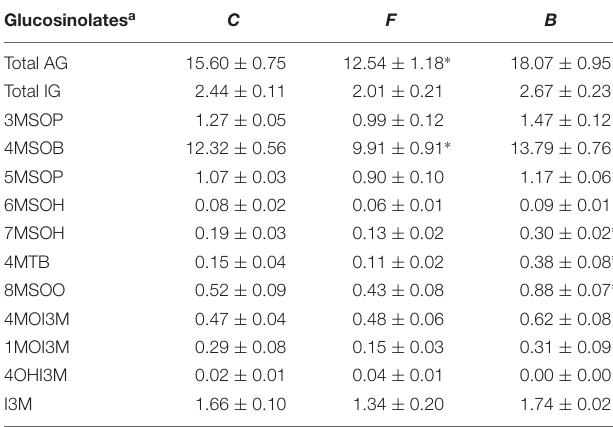
TABLE 2 | Mean ( ± SE) concentration of glucosinolates (GLS) ( µ mol g − 1 dry weight) in Arabidopsis thaliana leaves of Beauveria bassiana -colonised plants (F, FRh2; B, BG11; C,